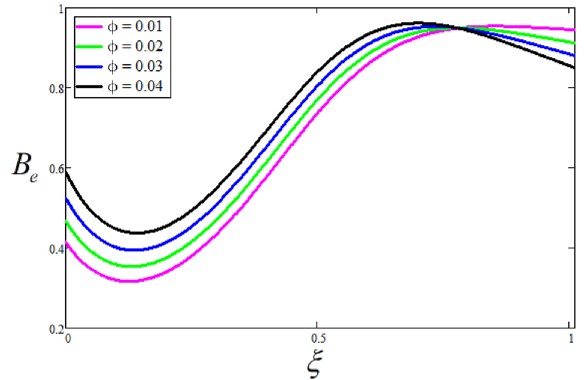
= 2, δ = γ = π , M = 5, k = 0.3, 3